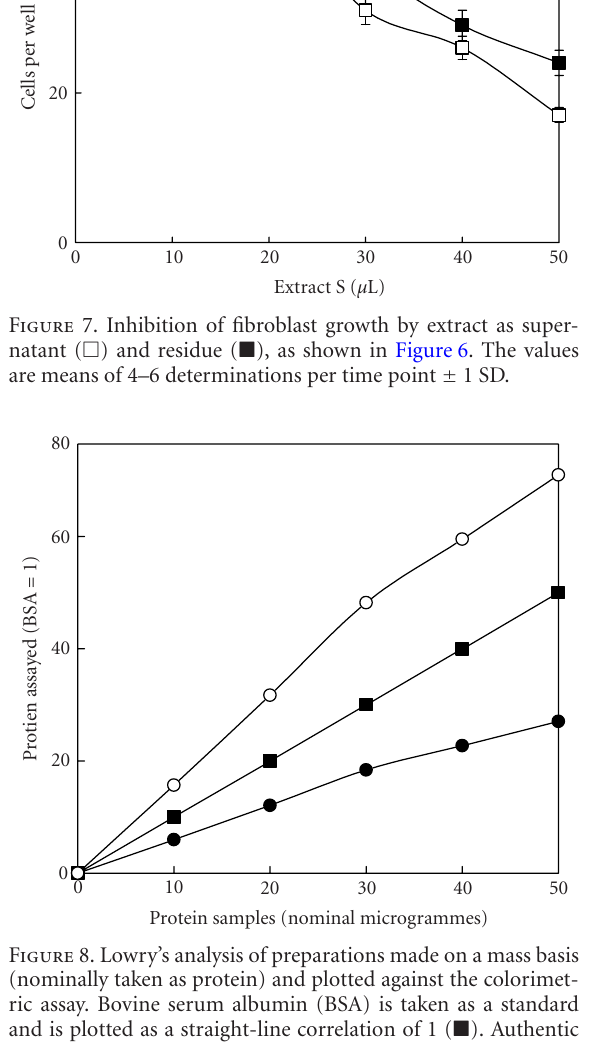
Figure 8. Lowry’s analysis of preparations made on a mass basis (nominally taken as protein) and plotted against the colorimet- ric assay. Bovine serum albumin (BSA) is taken as a standard and is plotted as a straight-line correlation of 1 ( (cid:2) ). Authentic • decorin ( ) is considerably below this line, indicating that its mass as a proteoglycan is underestimated by the Lowry assay. On the basis of protein relative to glycosaminoglycan in decorin (ie, ◦ ) has been plotted, which now indicates 118/45 kd), the curve ( an overshoot in estimation. Hence by inference, the preparation will be in core protein rather than the full-size proteoglycan (see Figure 3).